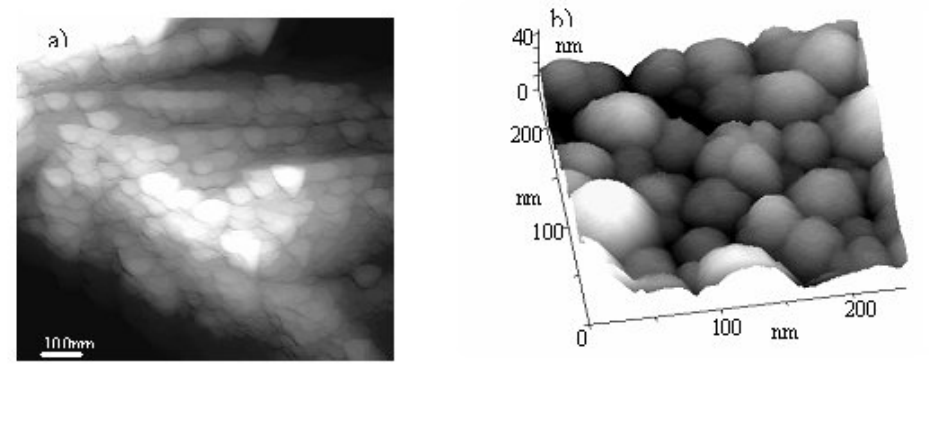
Figure 3. a) High resolution 1000x1000nm 2 contact AFM image acquired at a force setpoint of 20nN. The grey scale corresponds to a z-range of 140nm. b) 3D 250x250nm 2 constant current STM image acquired at a tip voltage of 3V and tunneling current setpoint of 0.6nA.